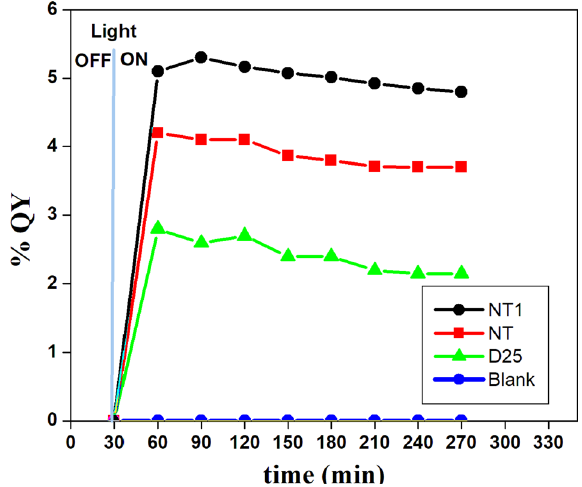
Figure 22. Overall QY of the samples at pH = 4 using Argon as purging gas.